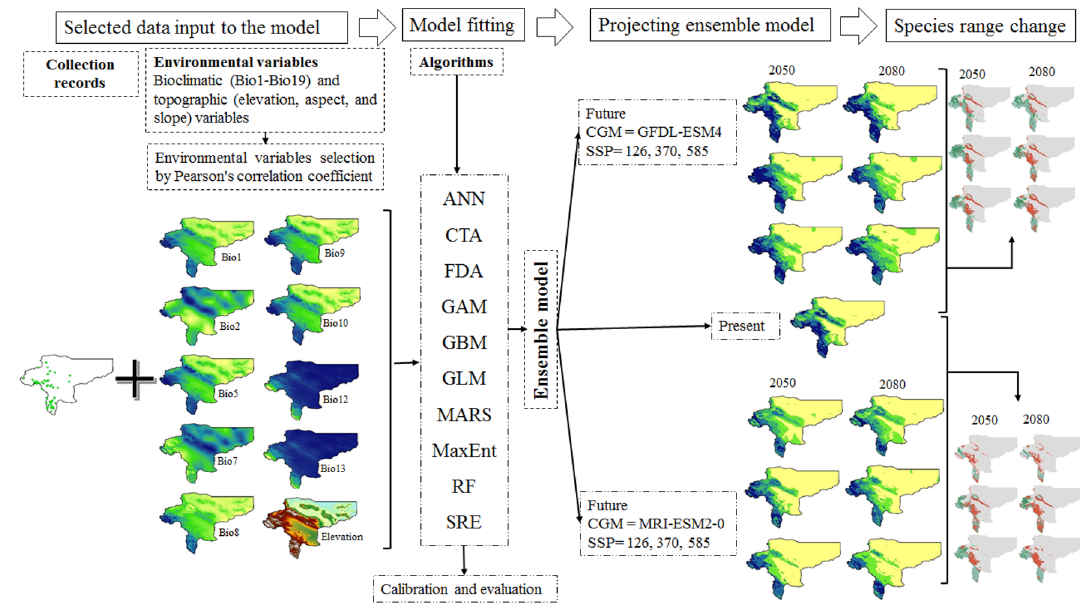
Figure 1. The modeling process of projected suitable habitat for S. inflata under current and future climate change conditions.